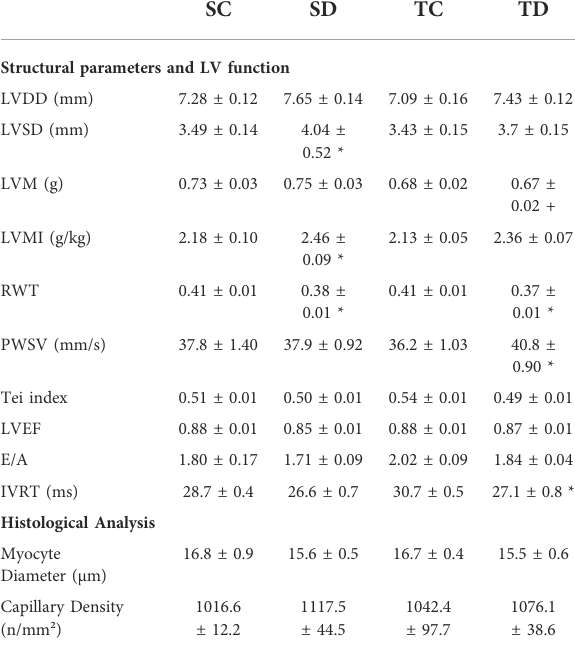
TABLE 3 Effects on DEX treatment and Combined Training on Myocardial structural parameters, heart function and histological analysis in SHR